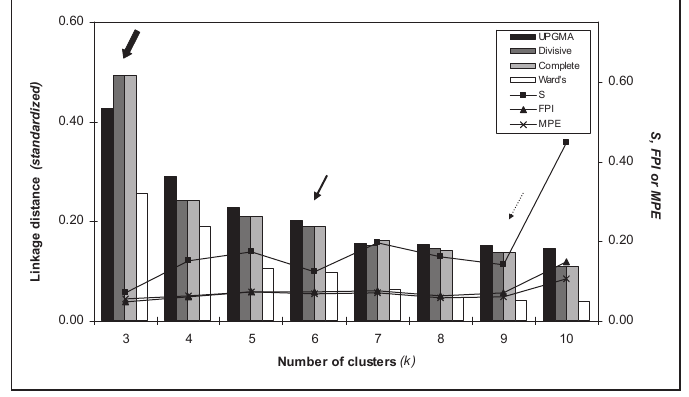
Fig. 4. Linkage distance (standardized across hierarchical methods) and fuzzy k -means performance measures in relation to number of clusters ( k ). Fuzzy performance measures include separate fuzzy validity (S), the fuzziness performance index (FPI) and modified partition entropy (MPE). The large solid arrow indicates the solution ( k = 3) that cor- responds with the null hypothesis (i.e., panmixia). For the hierarchi- cal methods, the decline in linkage distance reached a plateau at k = 5 or 6 (indicated by the small solid arrow). Minimum values for the three fuzzy performance measures were observed at k = 3, with local minima at k = 6 and 9 (indicated by the small dashed